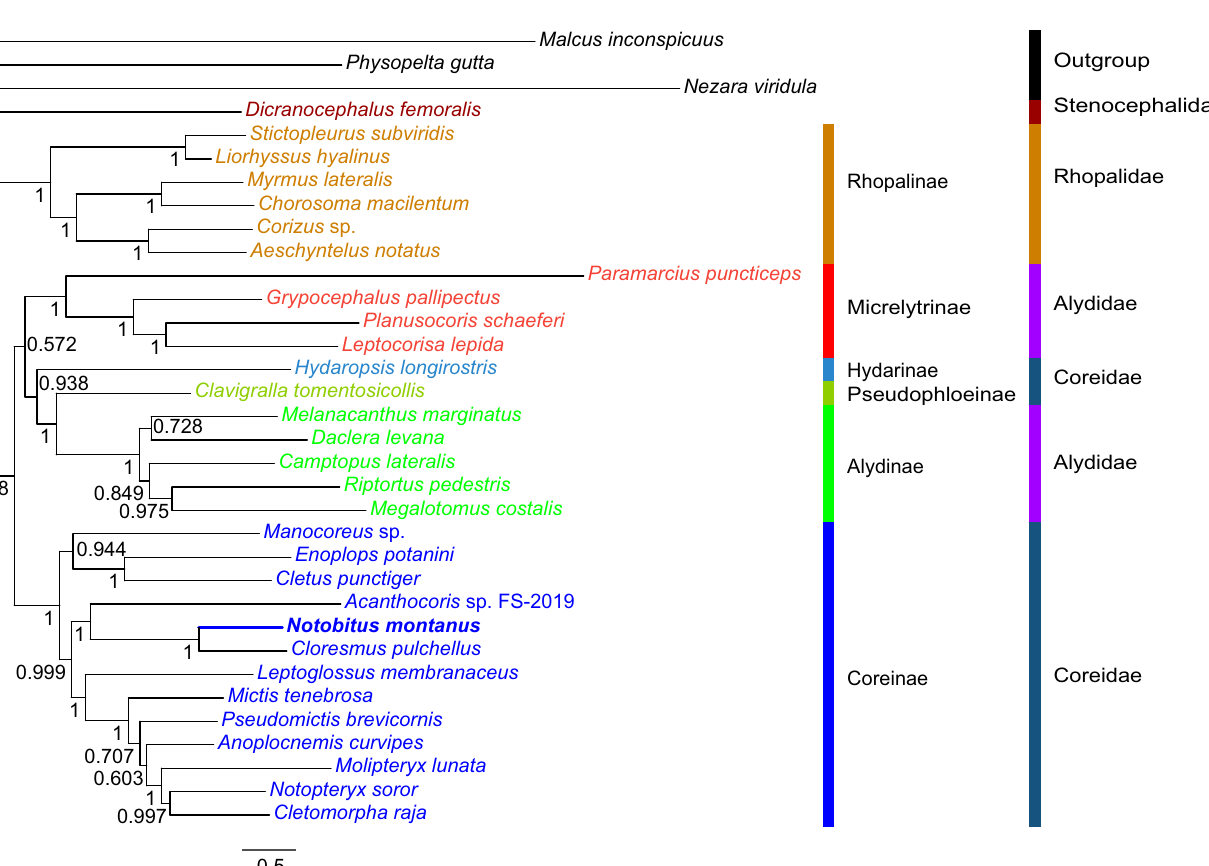
Fig 5. Tandem repeat sequences in the non-coding control region. The copy number of tandem repeats are shown by colored (blue, red, purple) oval with Arabic numerals. Non-repeat regions are indicated by green box with sequence size inside.